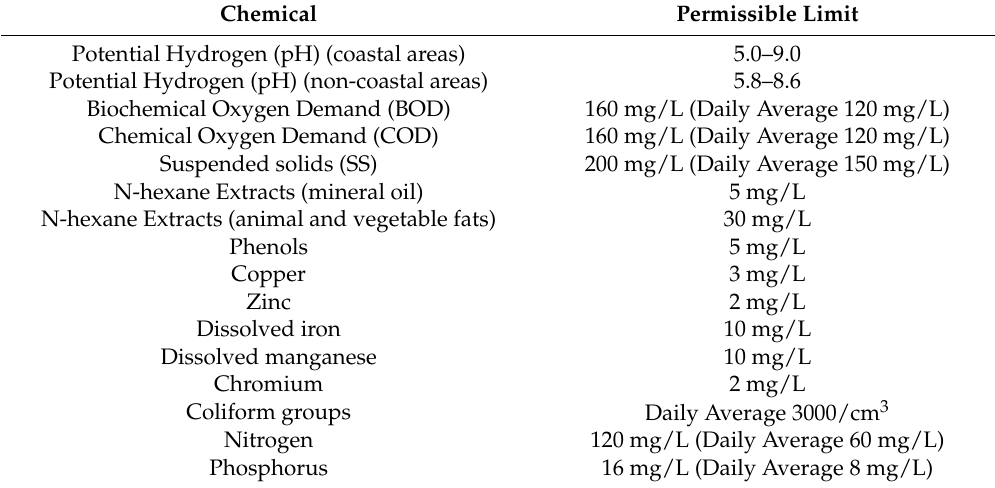
Table 1. Japan’s national effluent standards: items related to the protection of the living environment.